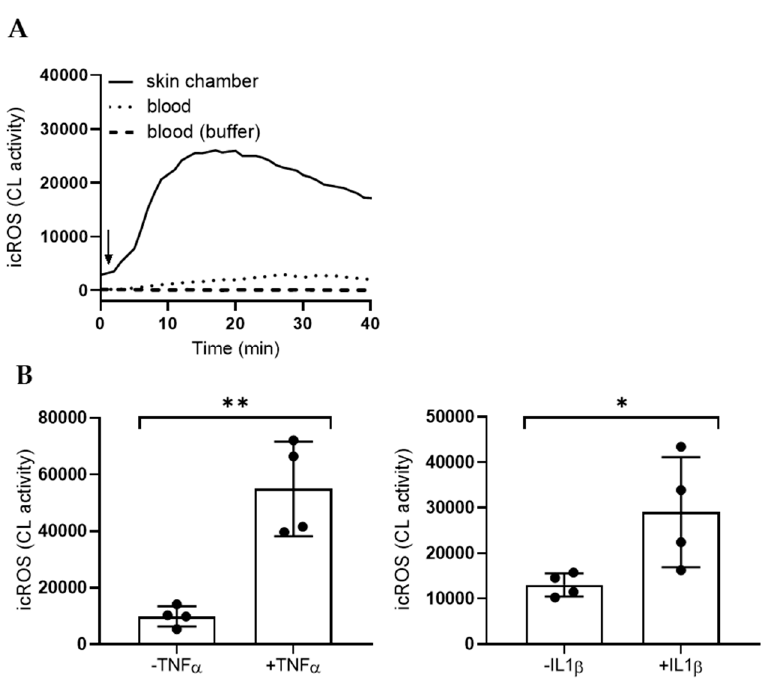
Figure 4. Increased responses to MSU crystals after in vivo transmigration or in vitro priming. ( A ) Tissue neutrophils derived from skin chambers (solid line) produced high amounts of intracellular ROS (icROS) in response to MSU crystals (300 µ g / mL) as compared to blood neutrophils (dotted line) from the same donor. A representative kinetic curve out of three independent experiments is shown. Arrow indicates addition of stimuli. ( B ) In vitro priming of blood neutrophils (20 min, 37 ◦ C) with IL-1 β (100 ng / mL) or TNF α (10 ng / mL) mimicked in vivo priming; increased icROS responses were seen in the primed neutrophils as compared to resting control neutrophils when treated with MSU crystals (300 µ g / mL). Peak values +/ − SD are shown and a paired t -test was used for statistical comparisons. * p ≤ 0.05 and ** p ≤ 0.01. ns = not significant.